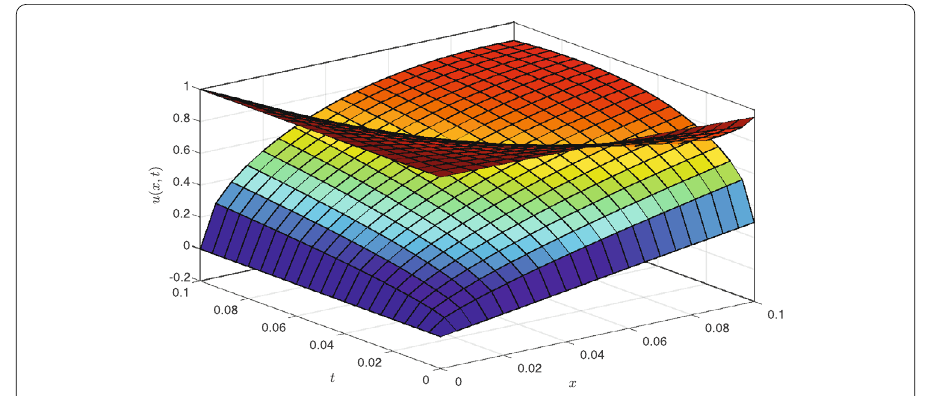
Figure 3 The approximate solution of Example 1 for Case 1 and α = β = 0.5